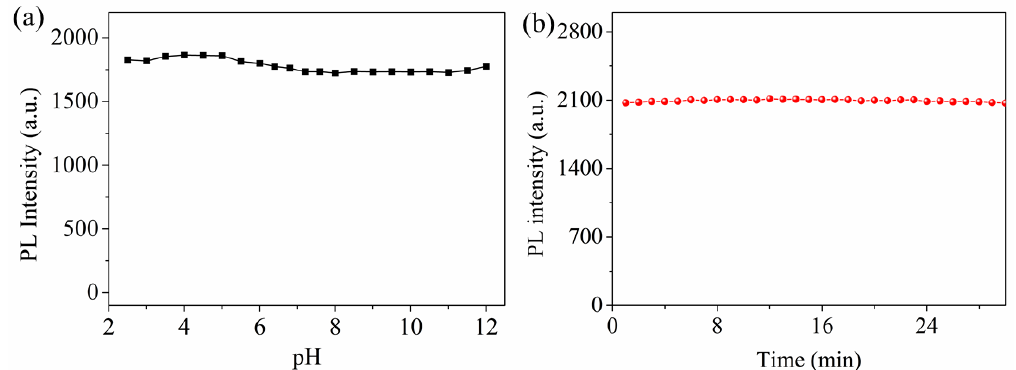
Figure 5. The photostability of WS-MSQDs ( a ) Fluorescence stability studies of WS-MSQDs in different pH solutions. ( b ) Fluorescence intensity of WS-MSQDs under excitation at 340 nm for 30 min.